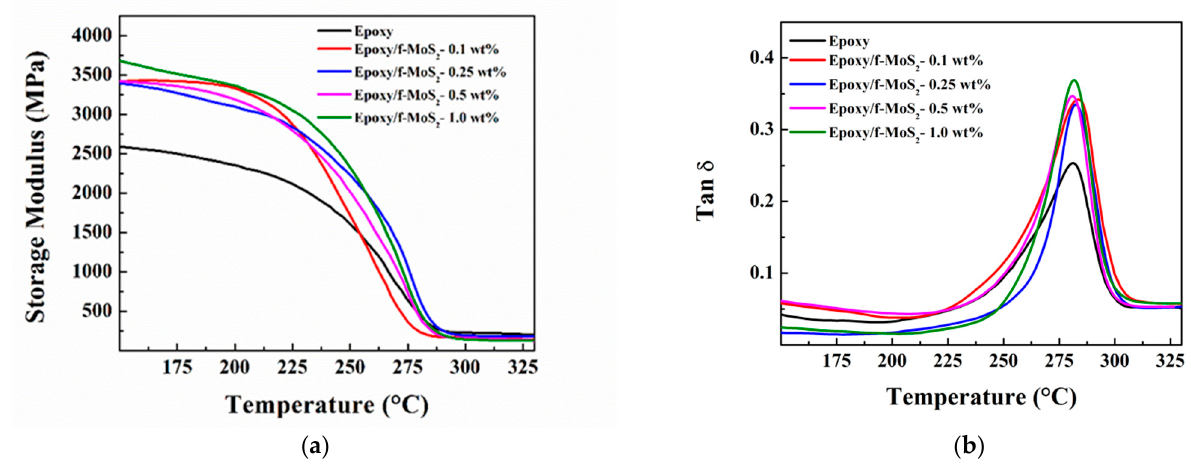
Figure 7. Storage modulus ( a ) and tan δ ( b ) vs. temperature of Epoxy & Epoxy/f-MoS 2 nanocomposites.